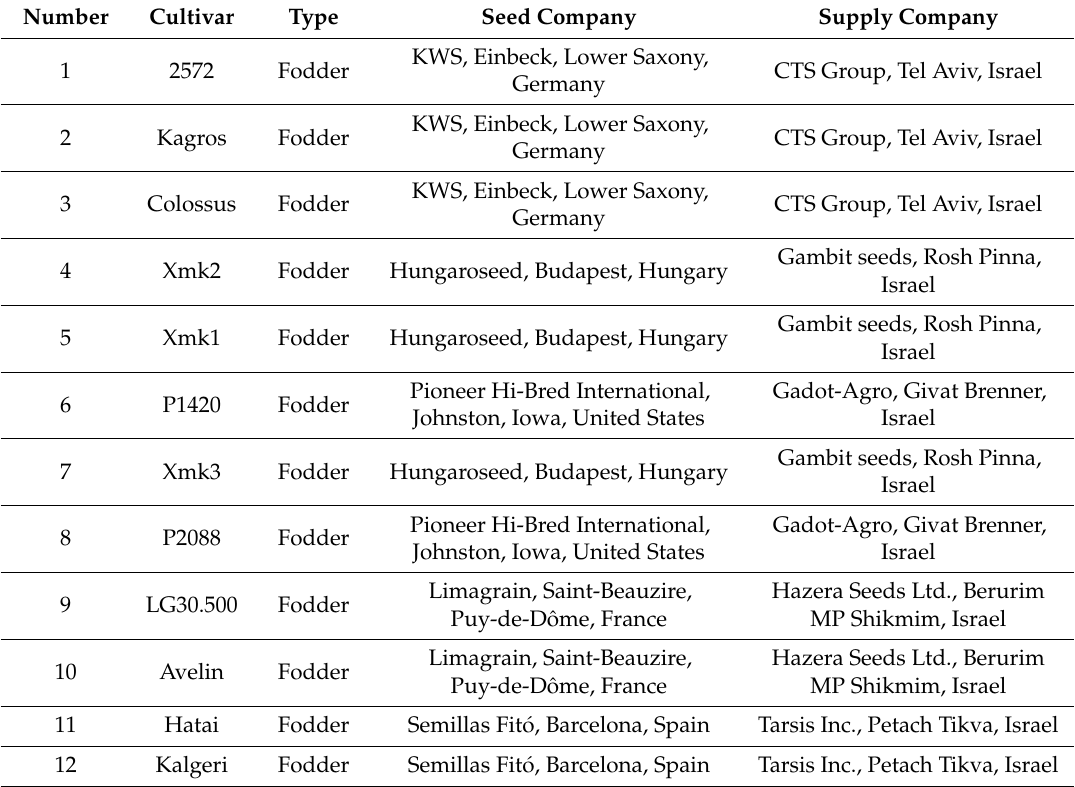
Table 1. Maize cultivars tested for late wilt disease sensitivity /